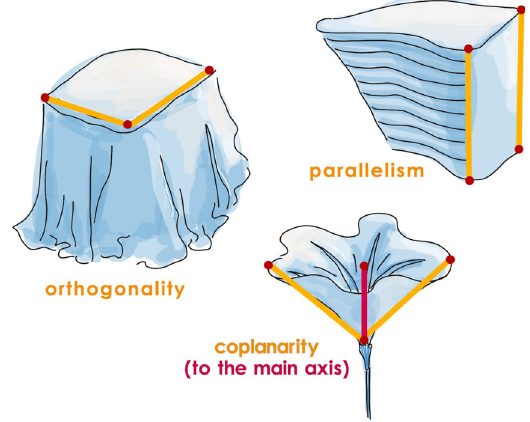
Fig. 3 User specified geometric